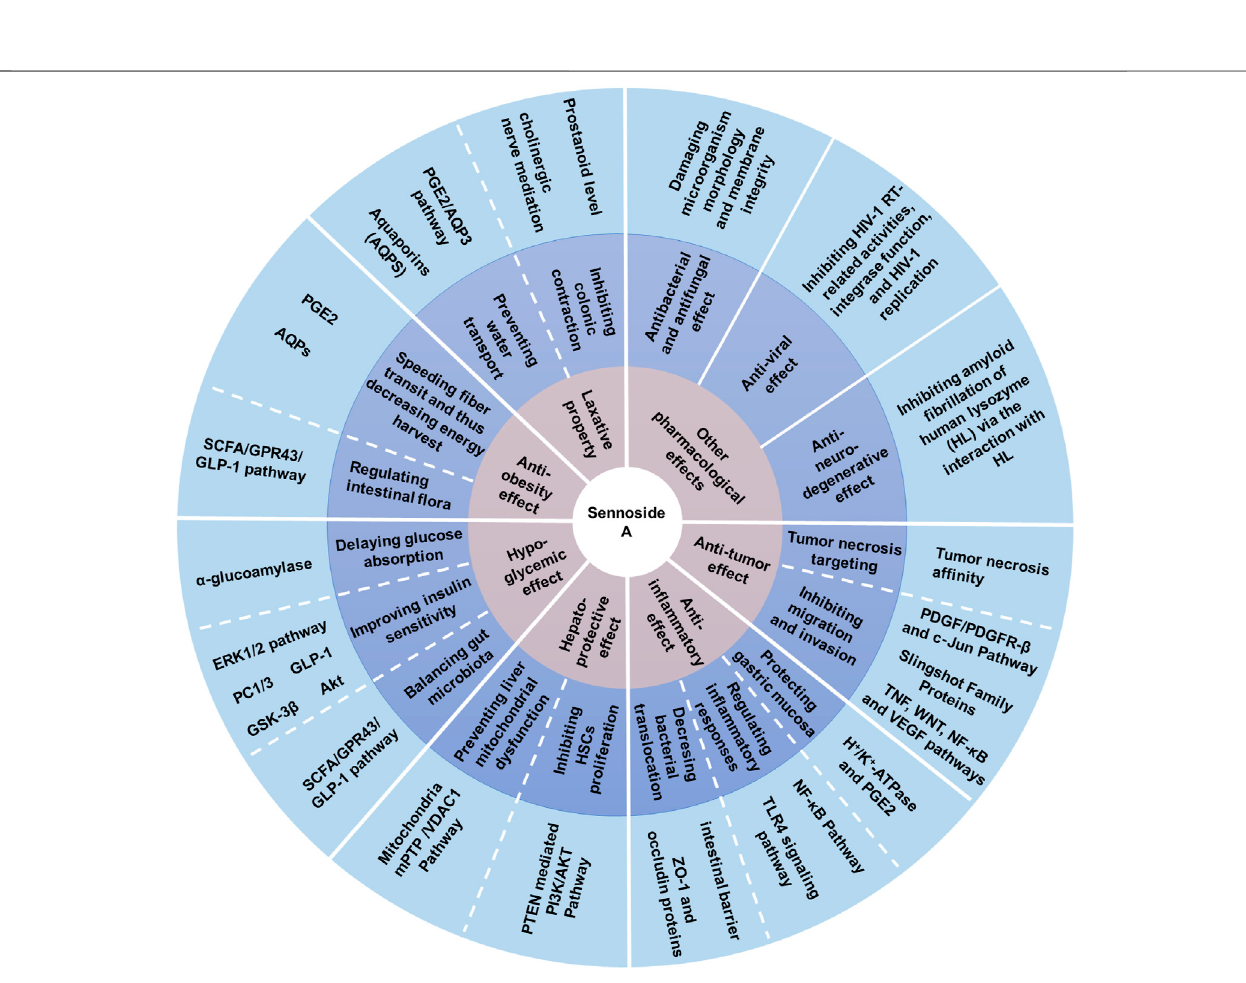
Frontiers in Pharmacology |